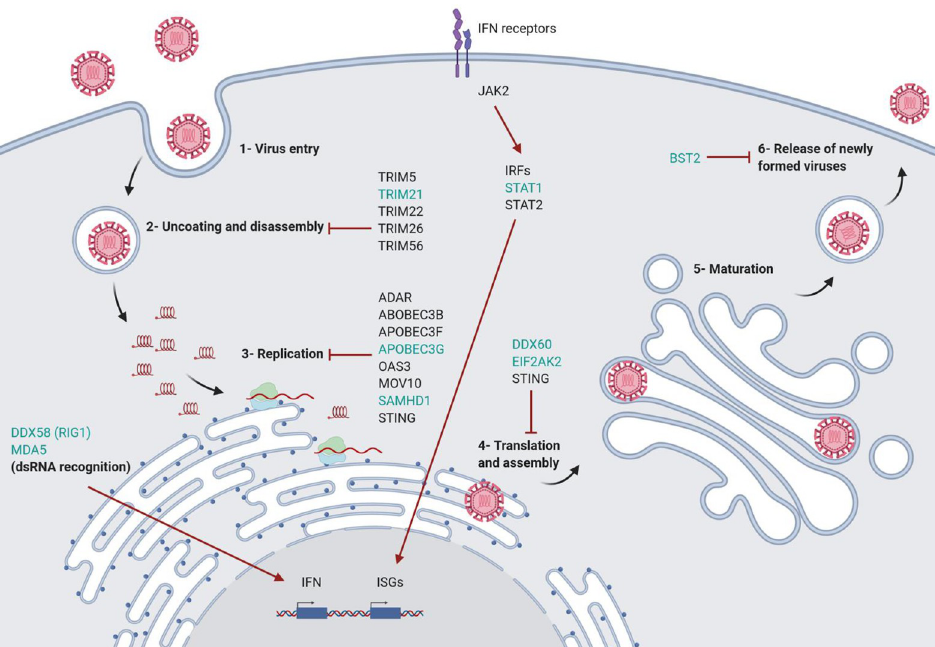
Fig 7. Genes upregulated following in vitro ZIKV infection in human myotubes and their role in antiviral responses. Cellular antiviral genes affecting different steps of virus replication were upregulated after ZIKV infection in myotubes but not in myoblasts (genes in black) or that were highly upregulated in myotubes (genes in green) when compared to myoblasts following ZIKV exposure. The ISG15, TRIM5, TRIM21, TRIM22, TRIM26 and TRIM56 genes are involved in the inhibition of virus uncoating and disassembly; ADAR, APOBEC3B, APOBEC3F, APOBEC3G, OAS3, MOV10, SAMHD1 and STING are related to the inhibition of viral replication; EIF2AK2, DDX60 and STING are inhibitors of translation and assembly of viral proteins; BST2 inhibits the release of new viral particles. IFIH1/ MDA5 and DDX58/RIG1 recognize viral double-stranded (ds) RNA and transcriptionally induce type 1 IFN, which is subsequently secreted; activation of JAK2, IRFs, and STATs 1 and 2 leads to the expression of interferon-stimulated genes (ISGs), which have different antiviral effects.